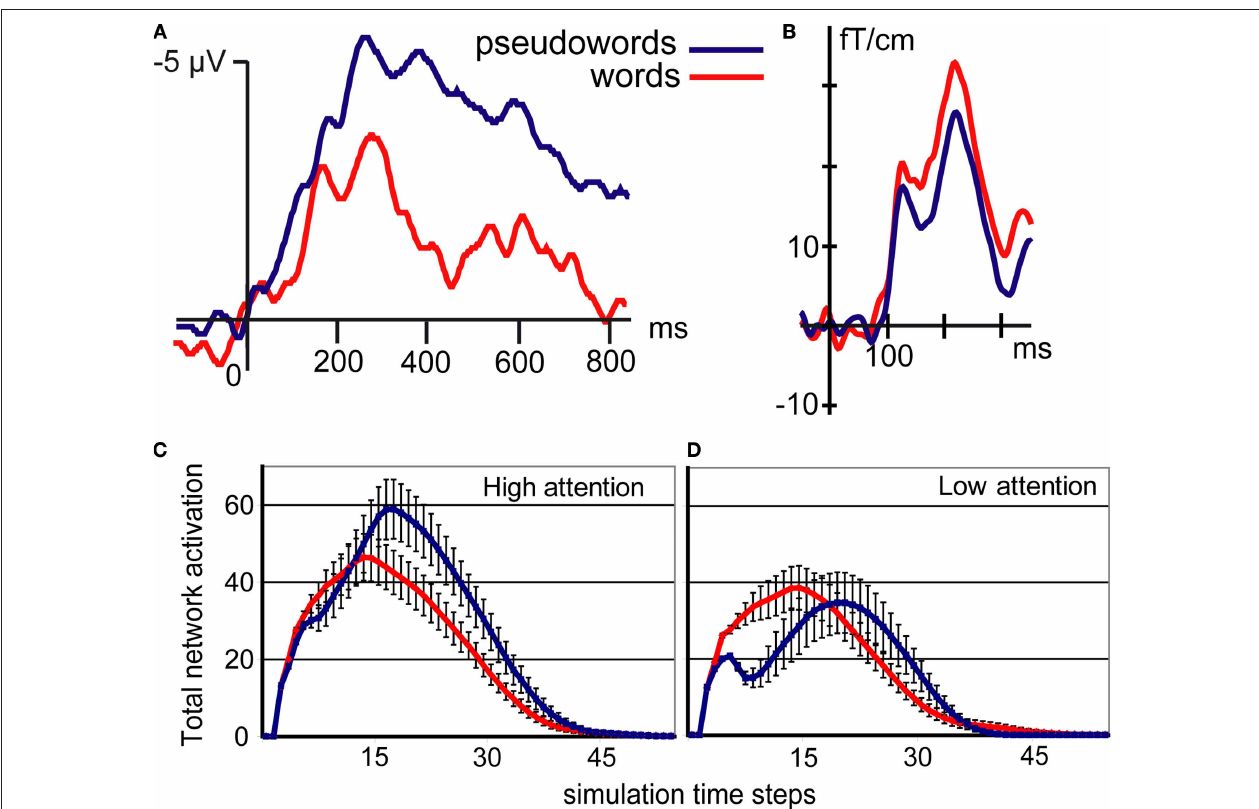
FIGURE 1 | Real (top) and simulated (bottom) brain responses to word (red) and pseudoword (blue) stimuli. (A) Typical N400 response. Note the large N400 amplitude to pseudowords (modifi ed from Friedrich et al., 2006; their Figure 3C). (B) Magnetic Mismatch Negativity (MMN) response; note that the MMN in word